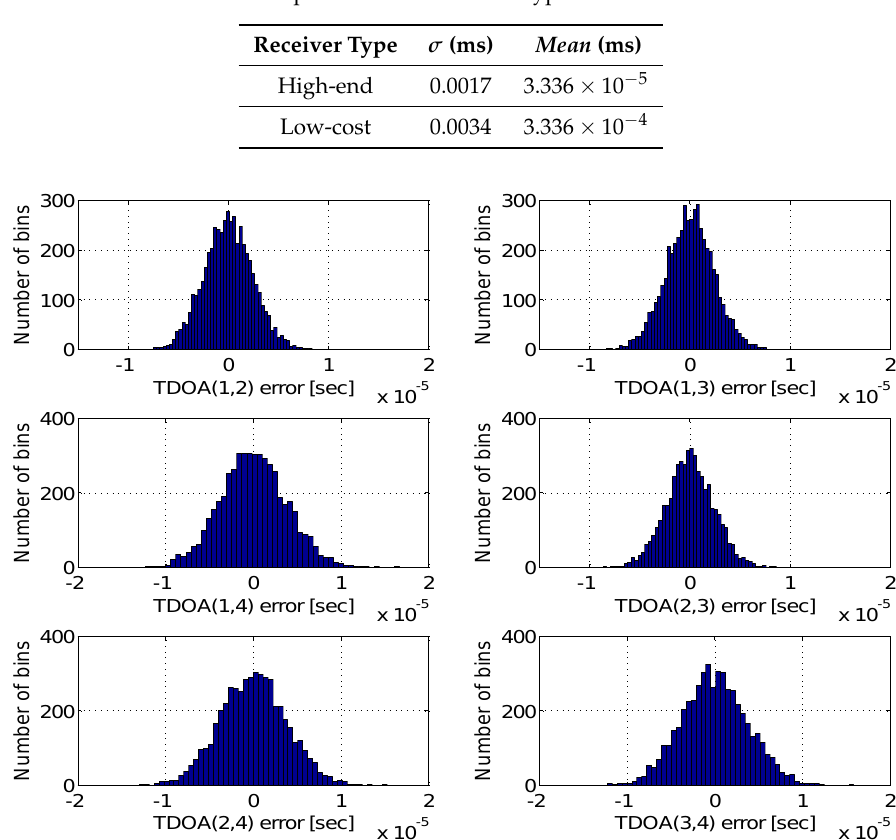
Table 3. TOA error parameters for the two types of simulated receivers.